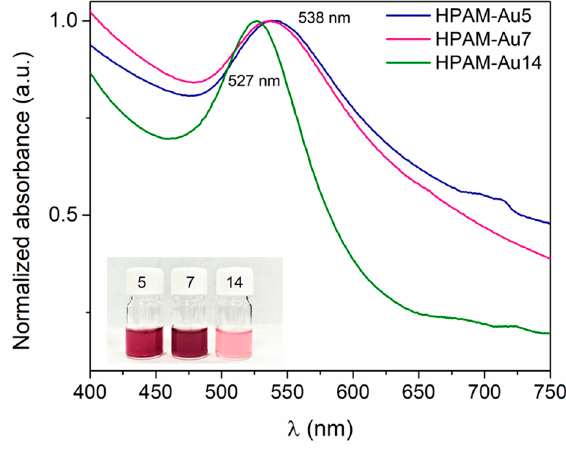
Figure 4. UV – Vis spectra of nanocomposites in aqueous solution: HPAM-Au5 (acidic), HPAM-Au7 Figure 4. UV–Vis spectra of nanocomposites in aqueous solution: HPAM-Au5 (acidic), HPAM-Au7 (neutral), HPAM-Au14 (basic). (neutral), HPAM-Au14 (basic).